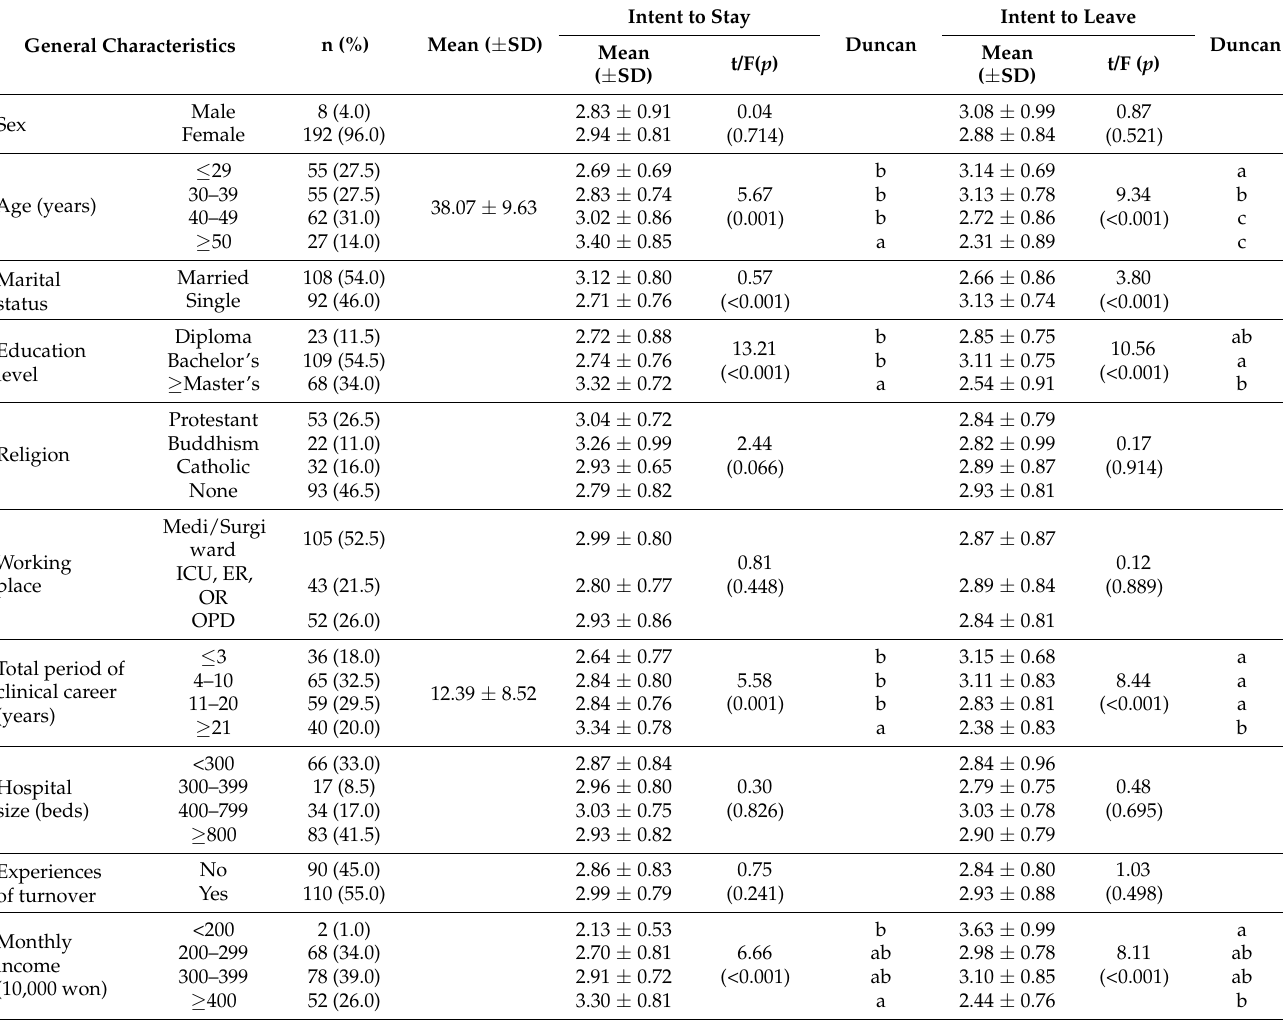
Table 1. Differences in the Intent to Stay or Leave based on Participants’ General Characteristics (n =